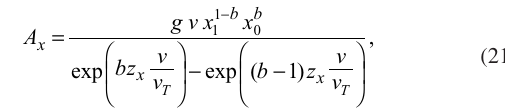
> 1 / 2 and q r N = K K K